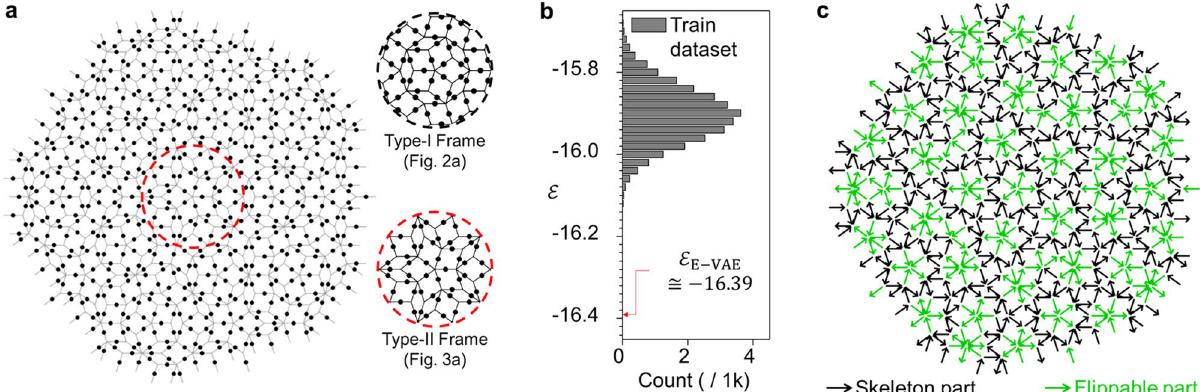
Figure 3. Structure and generated spin states of the Type-II Penrose P3 system. ( a ) The frame structure of Type-II system composed of 640 spins. Each circular dot represents where each spin is located. Two sub-figures show the magnified views around the center of Type-I and -II frame structures. ( b ) ε distribution for the training dataset. ( c ) The lowest energy spin state obtained from a trained E-VAE model with γ = 5.0 in Type-II system. ε E − VAE in (b) indicates the energy density value of the spin state shown in ground states are the ground state. For each of the specific five-fold vertices including the black arrows, only four configurations are degenerate as the ground state. This is less than half of the previously proposed ten-fold